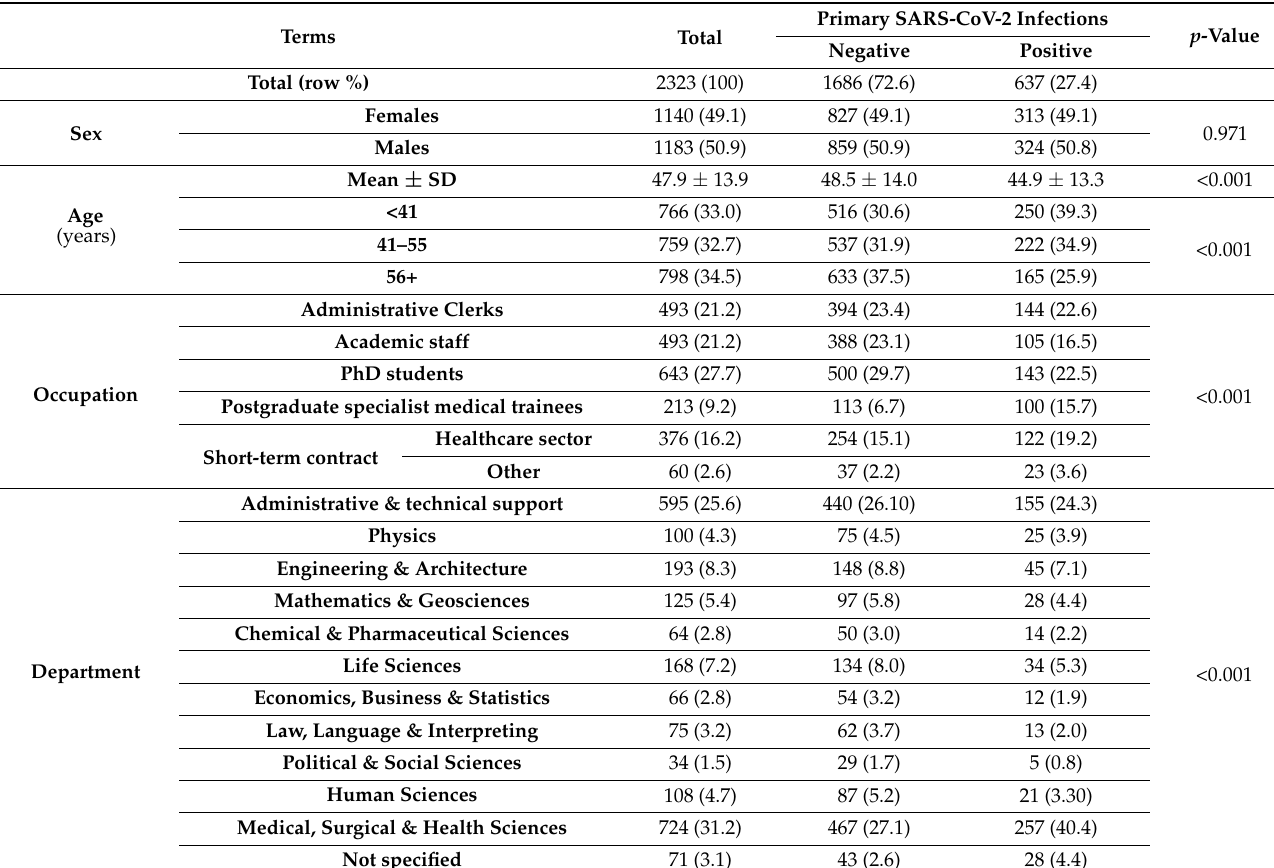
Table 1. Distribution of primary COVID-19 cases by explanatory factors. Number (N), percentage (%) and chi-square p -value. M = missing